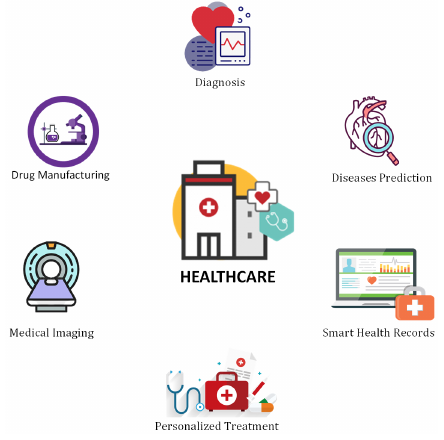
Figure 15. Applications of DL in healthcare. Table 4. State-of-the-art contributions in DL-based smart